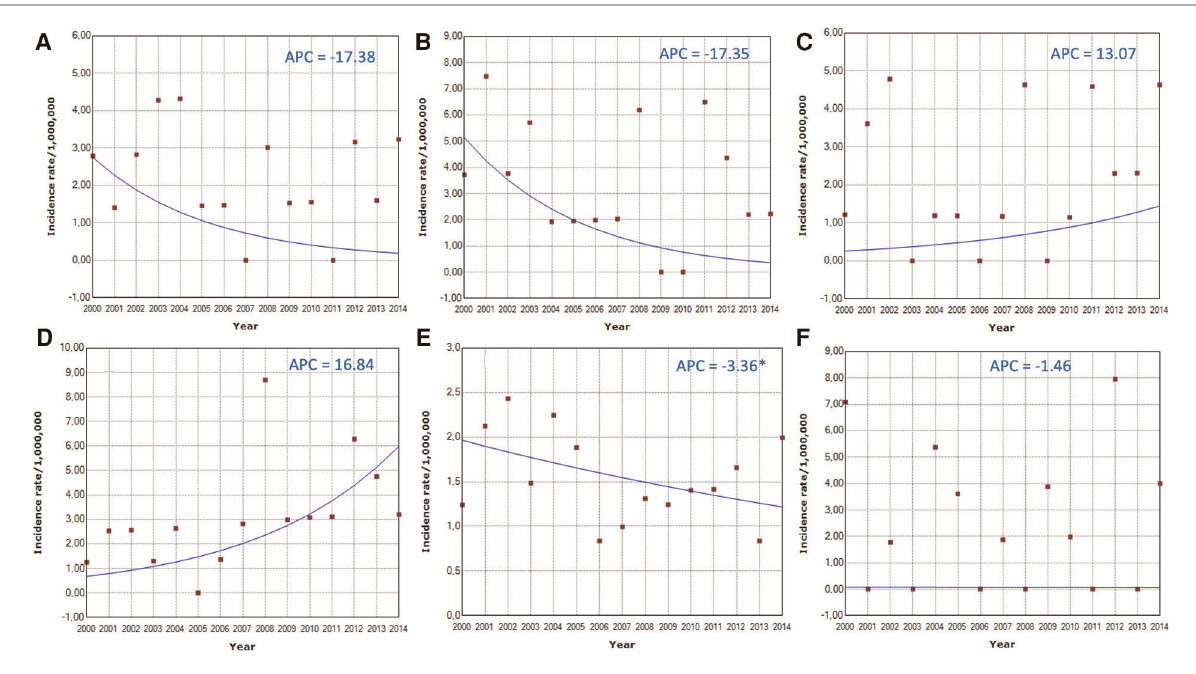
FIGURE 6 Time series from 2000 to 2014 demonstrating the trend in the incidence of retinoblastoma in children and adolescents aged 0 to 19 years in six Brazilian municipalities. ( A ) city of Belém and Ananindêua; ( B ) city of Recife; ( C ) city of Brasília (Federal District); ( D ) city of Belo Horizonte; ( E ) city of São Paulo; ( F ) city of Curitiba. Only the city of São Paulo showed a signi fi cantly downward trend (APC= − 3.36%). The others and the combined incidence showed stationarity (stable